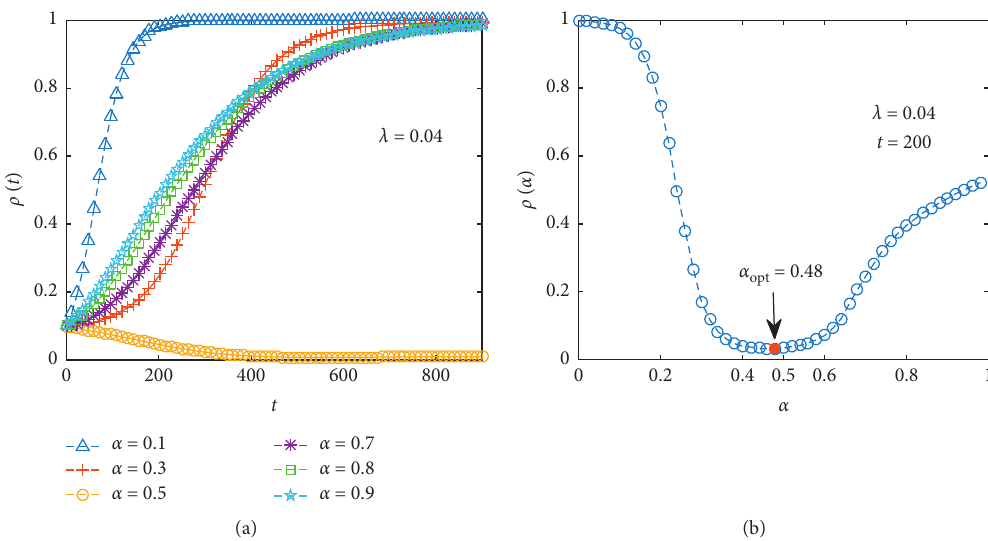
Figure 3: Effects of behavior response on evolution of the fraction of infected nodes ρ ( t ) . (a) The time evolution of ρ ( t ) for varieties of α using Monte Carlo simulations for a fixed value of λ � 0 . 04. (b) Plot of the fraction of infected nodes versus the change in α at a fixed time t � 200 and infection rate λ � 0 . 04. The results of the simulations are obtained by averaging over 300